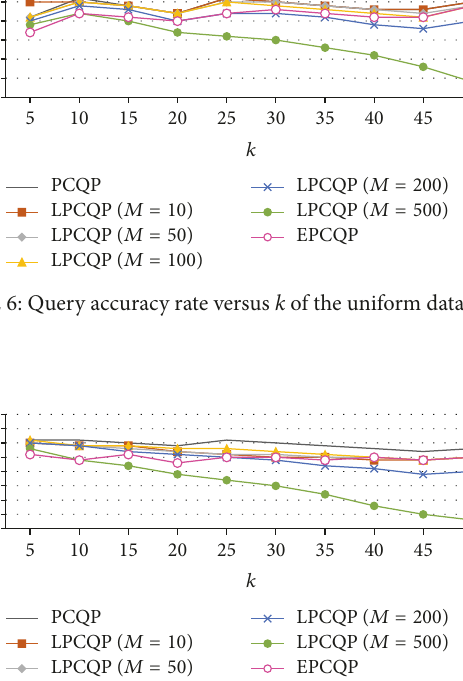
Figure 9: 𝛼 󸀠 versus k of the real-world